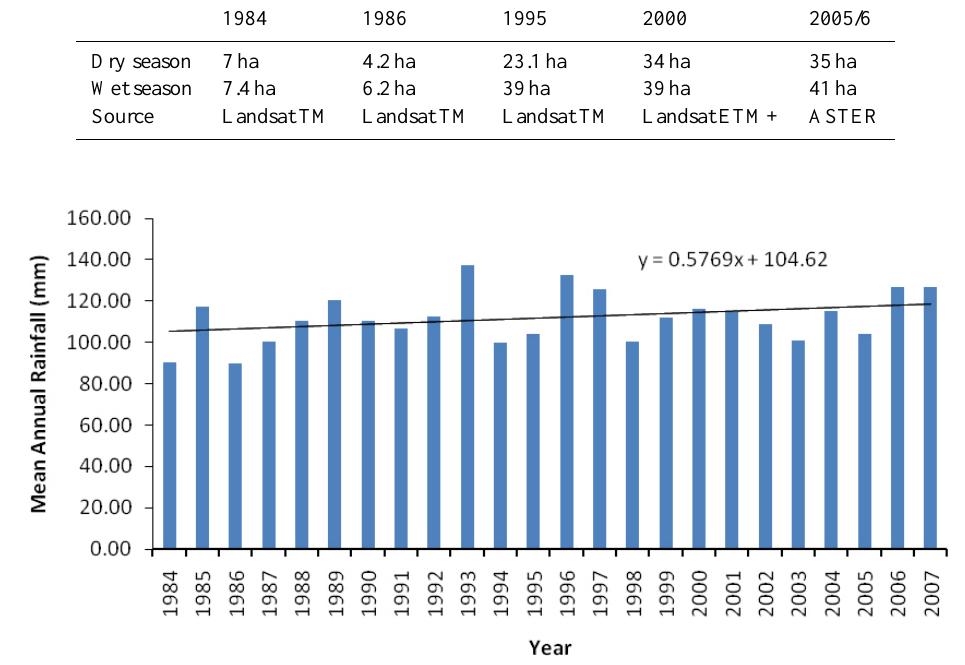
Fig. 6. The mean annual rainfall trend at Debre Markos station.